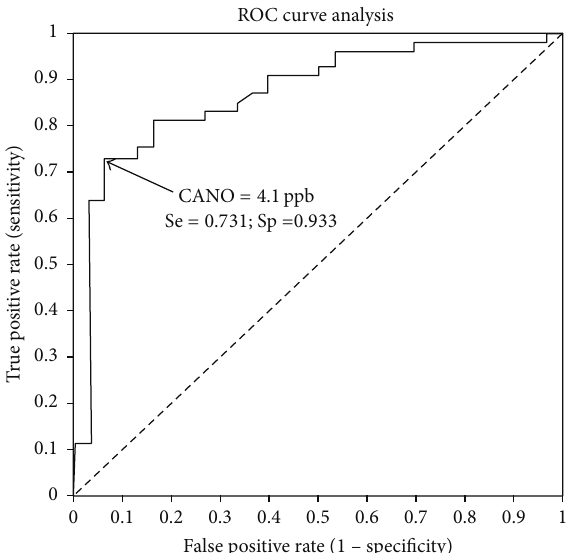
Figure 3: Receiver operating characteristic (ROC) curve of post- PSG CANO for predicting the subjects with OSA (AHI ≥